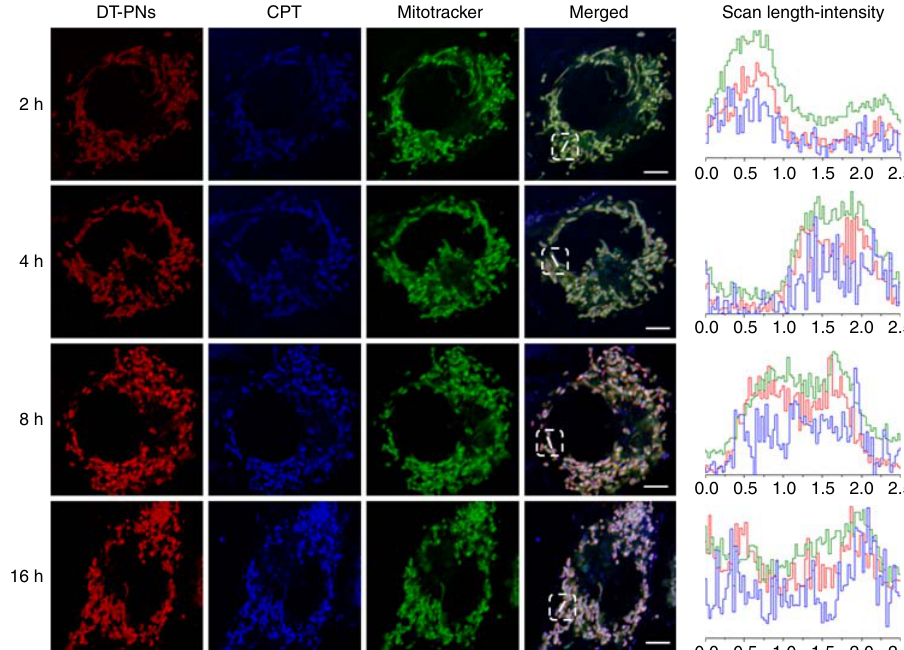
Fig. 4 Mitochondria-speci fi c localization and in situ drug release in mitochondria. 4T1 cells were treated with RhB-labeled DT-PNs for 2, 4, 8, and 16 h, respectively. RhB (red channel) was utilized to label the polymer backbone. Mitotracker (green channel) was employed to co-stain mitochondria. Blue channel was originated from the emission of CPT itself. In the line-scan pro fi les, the red, blue, and green curves represent the fl uorescence intensity from DT-PNs, CPT, and Mitotracker Green, respectively (scale bar, 5 μ